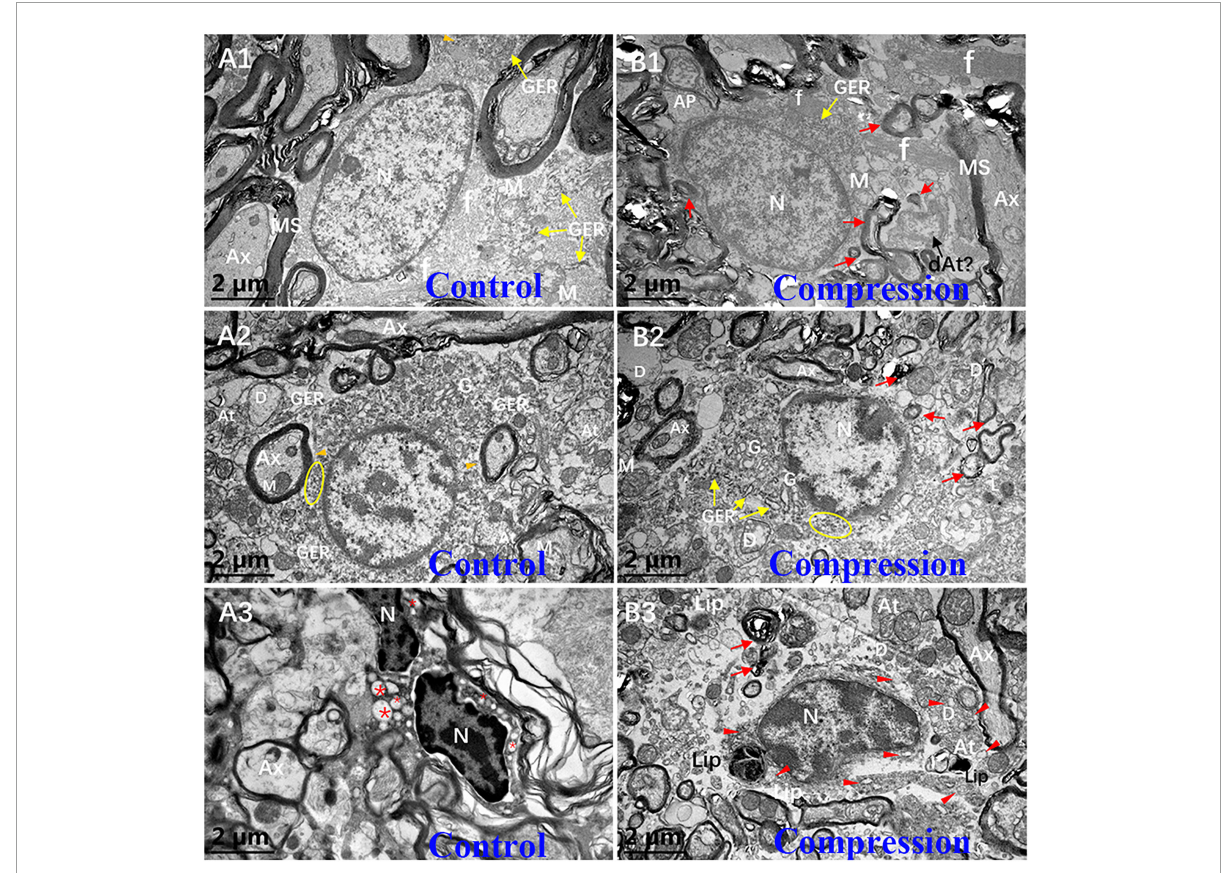
FIGURE7 Ultrastructural evidence of neuroglial cells degeneration. Astrocyte (A1,B1) , oligodendrocytes (A2,B2) , and microglial cells (A3,B3) in the control and CSM groups, respectively. N, nucleus; Ax, axon; MS, myelin sheath; f, filament; At, axonal terminal; D, dendrite; GER, granular endoplasmic reticulum; Lip, lipofuscin; L, lysosome; “*” empty phagocytic inclusion; yellow oval includes abundant of free ribosomes; orange arrowhead indicates a few of free glycogen granules in astrocyte; and red arrow indicates degenerating